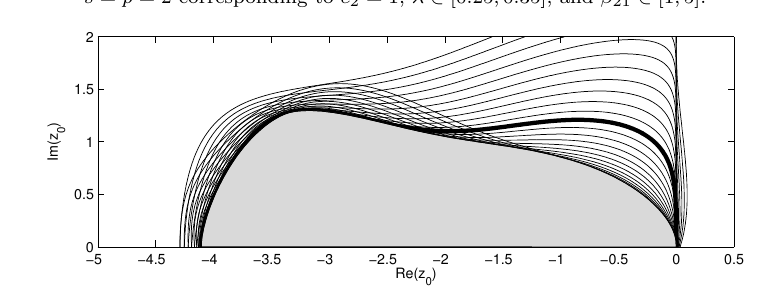
Figure 4. Contour plots of the area of stability region S π/ 2 of IMEX SDIRK methods for s = p = 2 corresponding to c 2 = 1, λ ∈ [0 . 25 , 0 . 35], and β 21 ∈ [1 , 5].